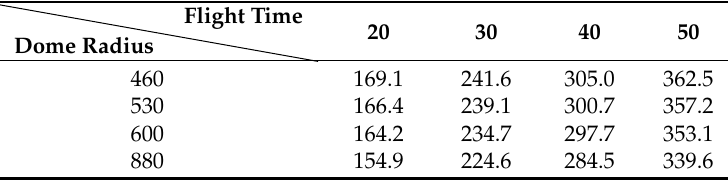
Table 1. Thermal diffusion at varying dome radiuses and flight times 1